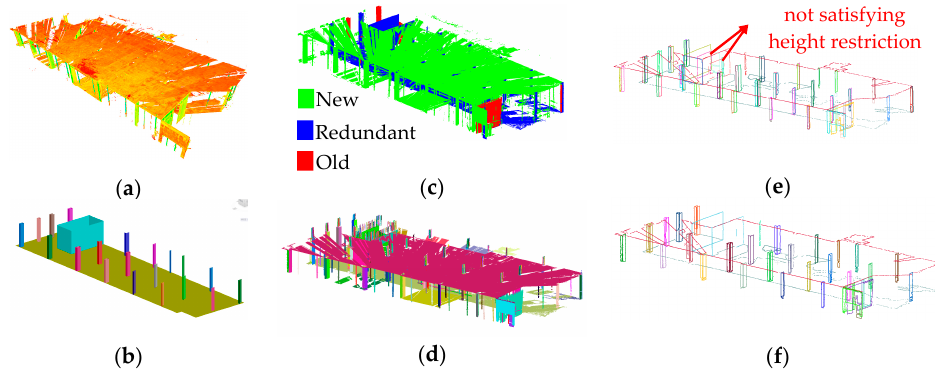
Figure 8. Epoch 2 redundant surface removal and column extraction: ( a ) point cloud of epoch 2; ( b ) generated model of epoch 1; ( c ) determination of new, redundant, and old points (Algorithms 4–6); ( d ) planar and linear segmentation of epochs 1 and 2 (adopted from [22]); ( e ) boundaries of planar segments after applying Algorithm 1; and ( f ) final set of extracted columns after Algorithm 2.